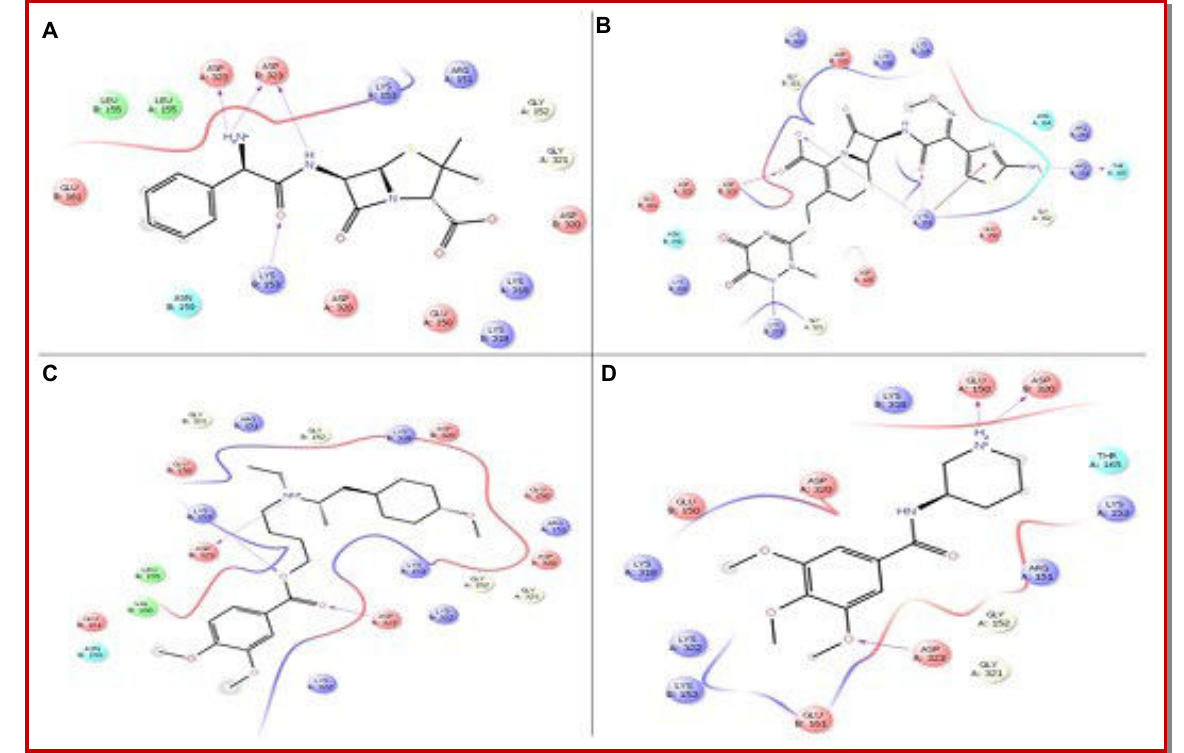
Figure 3: Ampicillin (A), ceftrioxone (B), mebeverine (C), troxipide (D) with IVQQ (PE binding protein 2a from MRSA